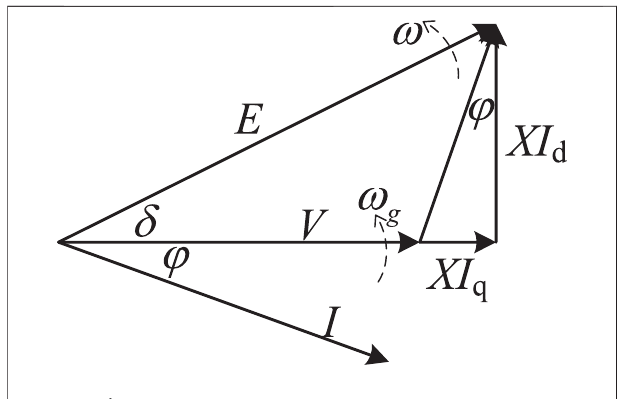
FIGURE 3 | Vector diagram of a